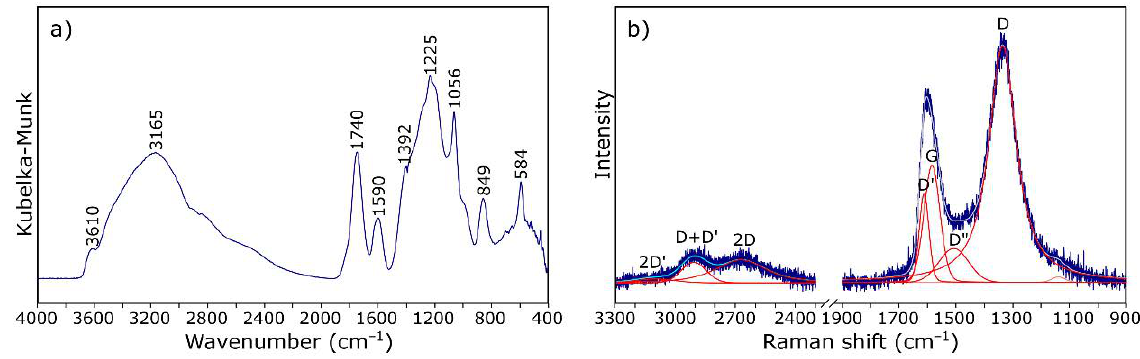
Figure 2. IR ( a ) and Raman spectrum ( b ) of graphene oxide